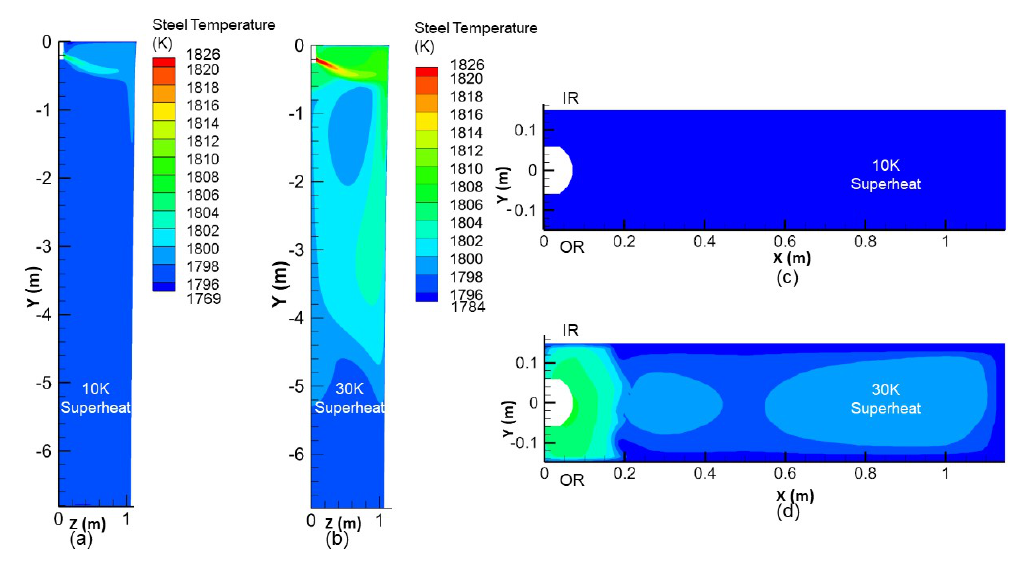
Figure 14. Temperature distributions: on the slab central plane front view for the ( a ) 10 K superheat and ( b ) 30 K superheat; near the top surface for the ( c ) 10 K superheat and ( d ) 30 K